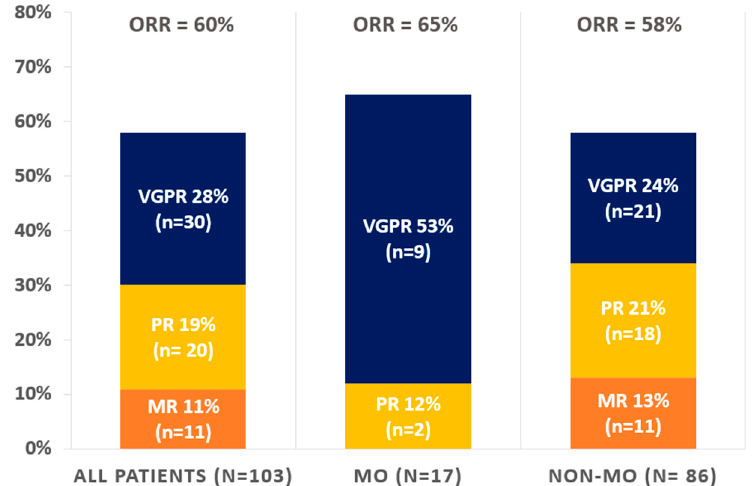
Figure 4. Overall response rate obtained in patients treated for relapsed or refractory multiple myeloma, according to a molecularly oriented (MO) or non-molecularly oriented (no-MO) treatment. MO: molecularly oriented, NON-MO: not molecularly oriented, ORR: overall response rate, VGPR: very good partial response, PR: partial response, MR: minimal response. In MO-treated patients, ORR was 65% (54% with at least VGPR) and in no-MO pa- tients the ORR was 58% (24% with at least VGPR) ( p = 0.053) (Figure 4). The median vari- ation in measurable monoclonal component in serum was a decrease of 91% in MO- treated patients and decrease of 30% in no-MO treated patients ( p = 0.33) (Figure 5).